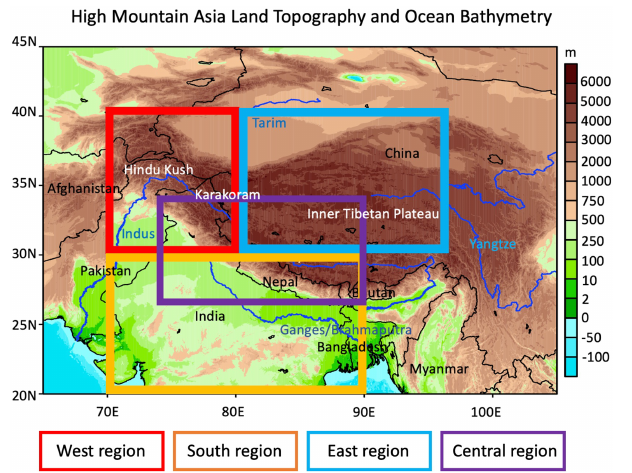
Figure 1. Topography and ocean bathymetry using the NOAA Na- tional Geophysical Data Center’s ETOPO1 global relief model. The map shows the elevation (m) for the HMA domain. The topography shown in this map is not the same as the topography used by GEOS- S2S, which has a coarser representation of the actual topography in the HMA region. In this figure, countries are in black text, moun- tain ranges are in white text, and main rivers that are in major basins are in blue text. Four subregions are defined for additional analysis, where the west region shown in red includes the Hindu Kush and Karakoram mountains, the south region includes the Indian subcon- tinent, the east region includes the Inner Tibetan Plateau, and the central region includes the